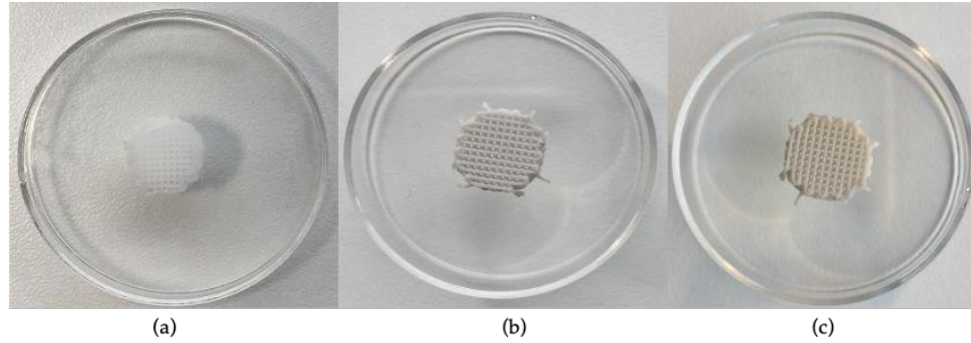
Figure 2. Observation of the 3D-printed scaffolds for each group: ( a ) PCL scaffolds; ( b ) PCL scaffolds with the addition of hydroxyapatite nanoparticles; and ( c ) PCL/HANp scaffolds submerged in PEGDA solution.